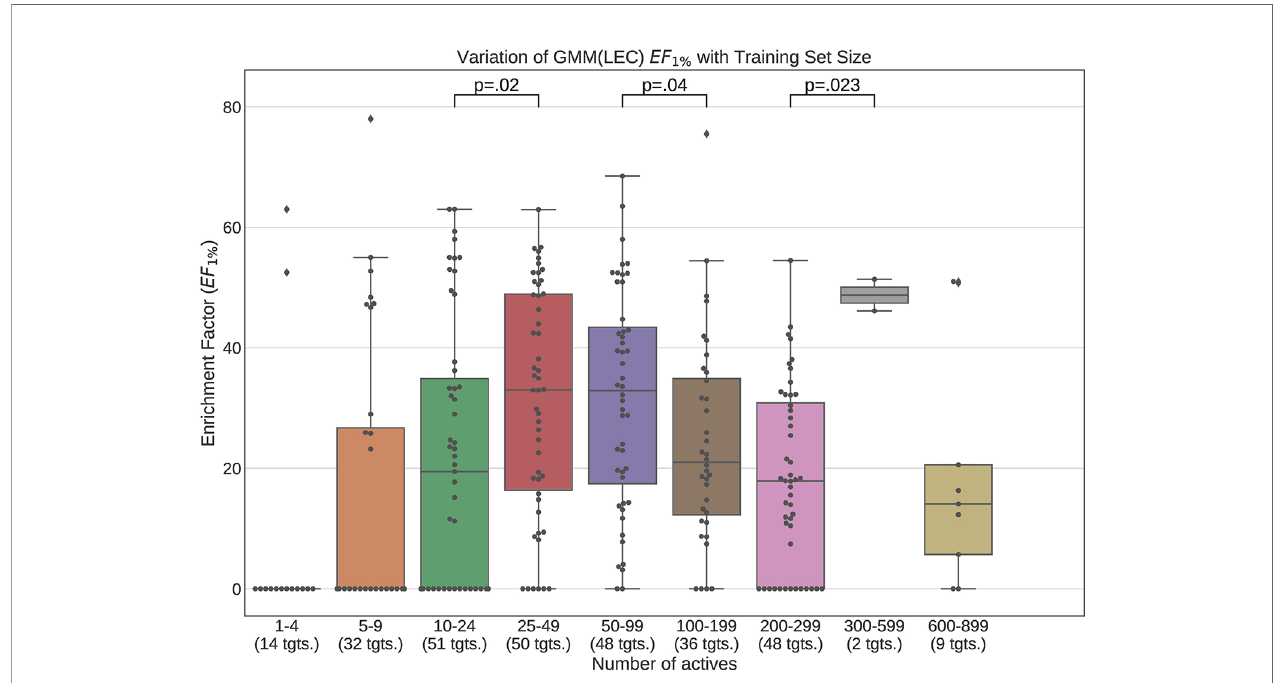
FIGURE 13 | Performance variation of Lowest Energy Conformation (LEC) model Gaussian Mixture Model with number of actives. Scatter plot indicates one point per template within the given range. The number of templates captured within the range is indicated in the axis labels. Note that multiple points belonging to the same target could fall within a single range due to the binning thresholds